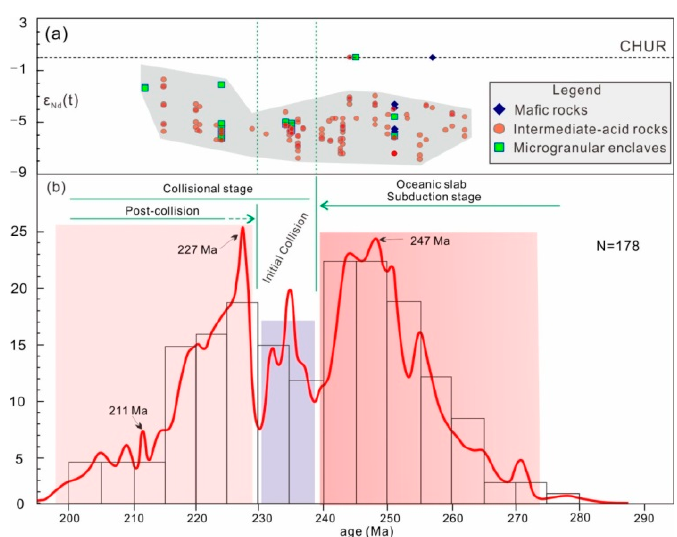
Figure 13. ( a ) Plot of formation age (Ma) and ε Nd ( t ), and ( b ) zircon U-Pb age data histograms and probability density curves for the Late Paleozoic–Early Mesozoic magmatic rocks. The values of ε Nd ( t ) from Yu et al. [22]. Age histograms are from Li [139]. Recently, Zhao et al. [80] reported 266 Ma tholeiitic gabbros from the central part of the Burhan Budai arc (i.e., the Kengdenongshe area). Based on their REE signature, the